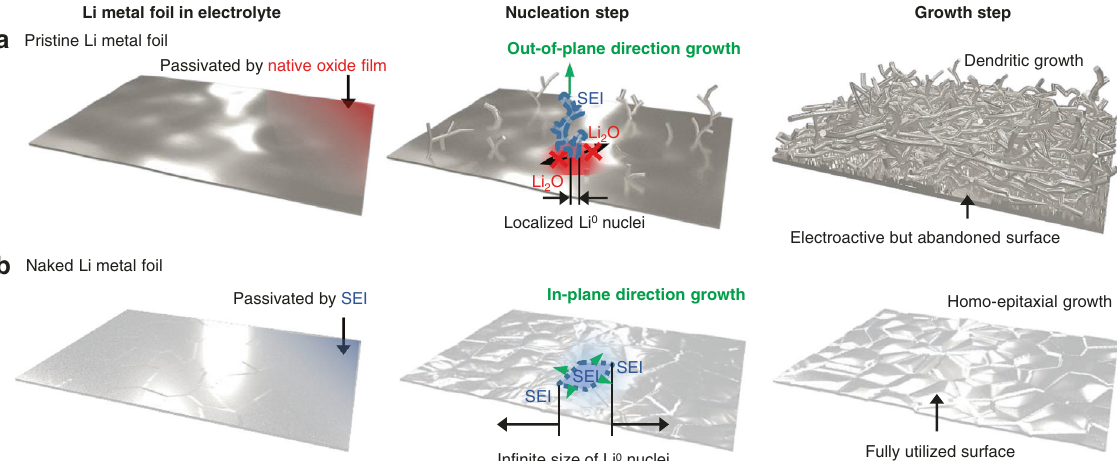
Fig. 1 | Importance of the surface state in controlling the morphology of Li deposit. Schematicillustrationofthenucleationandgrowthstepsof a ,thepristine and b ,nakedLimetalfoils.Theredandblueshadingrepresentstheexistenceofthe